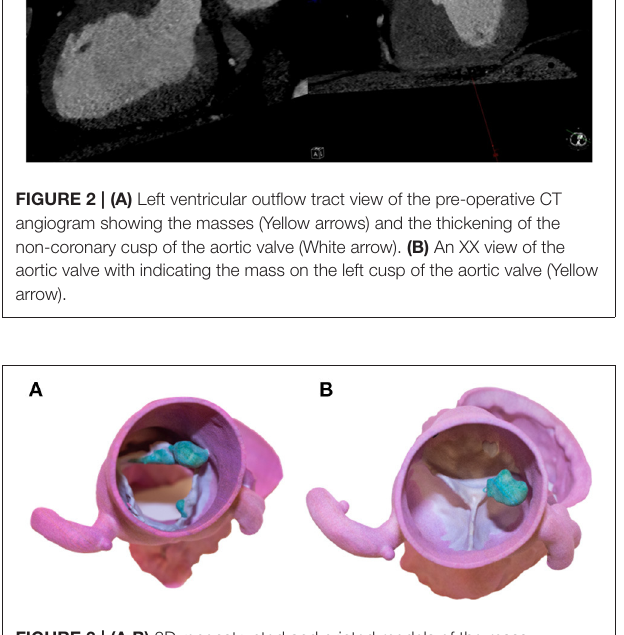
FIGURE 3 | (A,B) 3D reconstructed and printed models of the mass.